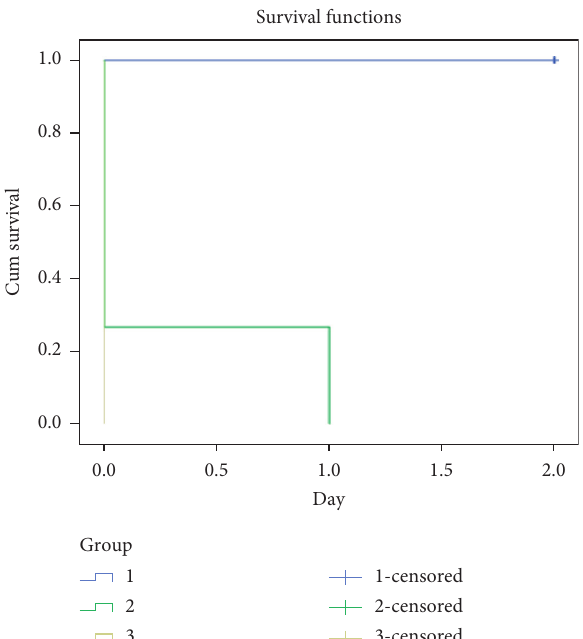
Figure 1: Subacute toxicity effect of arsenic on the survival rate of adult Javanese medaka treated with different concentrations of arsenic (0.5–4mM). The percentage of survival rate is shown versus concentration of arsenic. ∗ P < 0 . 001 represents significant different values of the control group and group exposed to arsenic. The values represent mean ± SD from three ( n � 3) independent experiments.